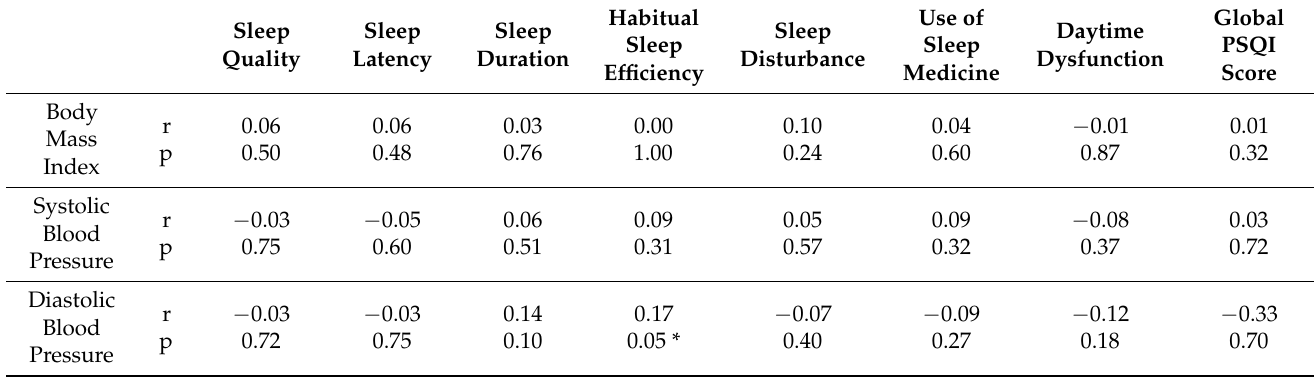
Table 4. Correlations between Pittsburgh Sleep Quality Index and physiological variables.